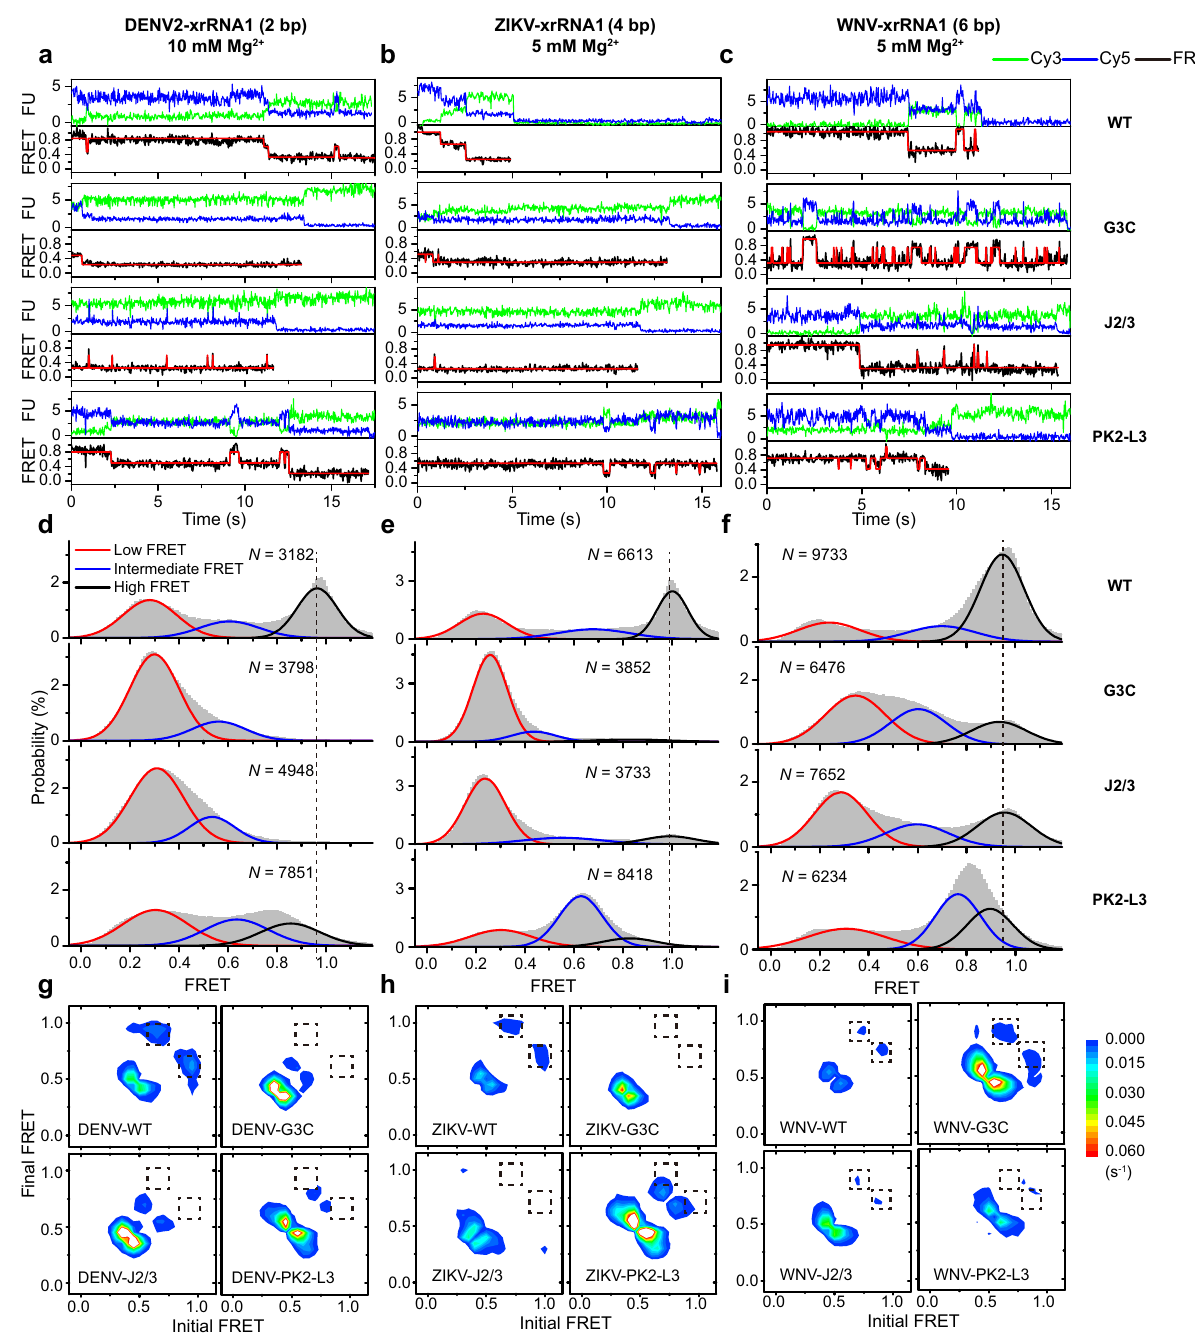
Fig. 6 Mutations at key tertiary motifs affect the conformational ensembles of fl aviviral xrRNAs. a – c Representative smFRET traces for the wild type, PK1, J2/3 and PK2-L3 mutants of DENV2-xrRNA1 ( a ), ZIKV-xrRNA1 ( b ), and WNV-xrRNA1 ( c ) at 10 mM Mg 2 + , 5 mM Mg 2 + , and 5 mM Mg 2 + , respectively. The idealized FRET traces generated by the hidden Markov model (red) were overlaid on the experimental FRET trace (black). d – f FRET histograms for the wild type, PK1, J2/3, and PK2-L3 mutants of DENV2-xrRNA1 ( d ), ZIKV-xrRNA1 ( e ), and WNV-xrRNA1 ( f ) at the corresponding Mg 2 + . N denotes the total number of traces used to generate each histogram from three independent experiments. g – i Transition density plots (TDPs) for DENV2- xrRNA1 ( g ), ZIKV-xrRNA1 ( h ), and WNV-xrRNA1 ( i ) mutants. TDPs were generated from all smFRET traces of three independent experiments. The dashed boxes highlight the absence or presence of transitions between I state and H state for xrRNAs mutants. Source data are provided as a Source Data fi